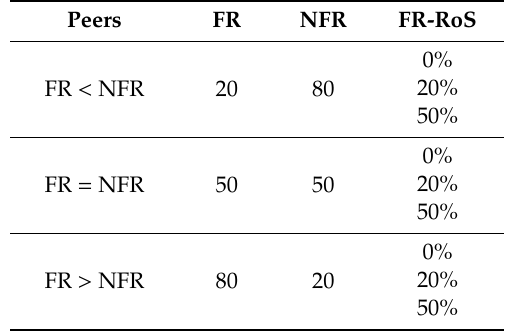
Table 3. Experimental setting: In all scenarios, the system was operated with 100 peers, 300 files, and 3000 transactions. (FR = free rider, NFR = non-free rider, FR-RoS = free riders’ rate of sharing).